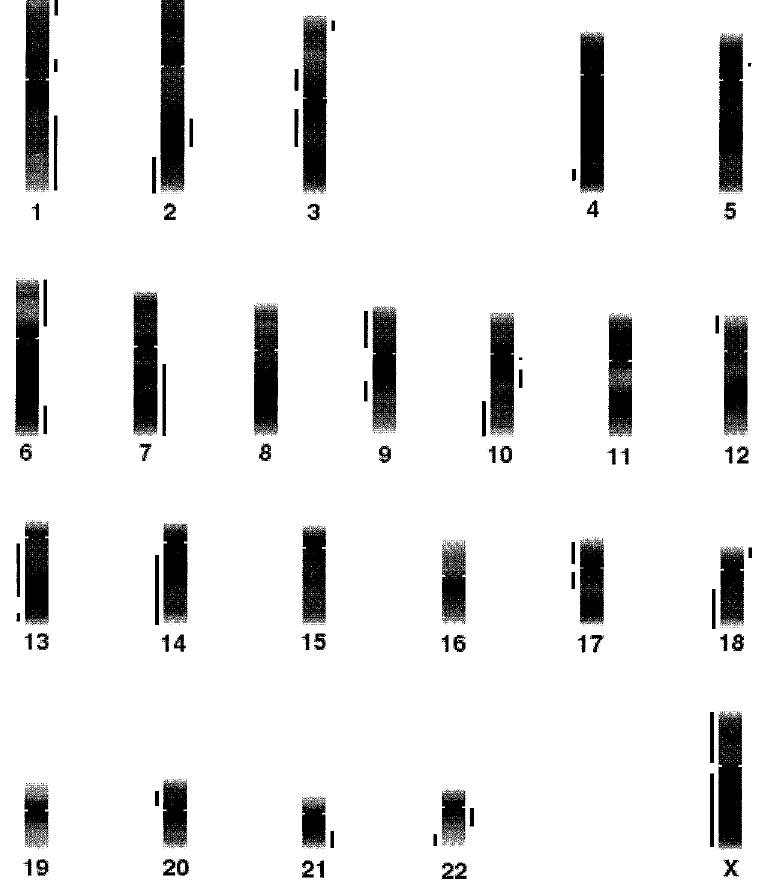
Fig. 2. An ideogram of the mean inverted DAPI stained chromosomes, showing the copy number imbalances found by CGH analysis of pure, unsorted K-562 cells. Deletions are shown as bars to the left of the chromosome and amplifications as bars to the right. The analysis resulted in 30 autosomal aberrations, including a minute pericentromeric amplification on chromosome 10q not found in any of the sorted K-562 subpopu-